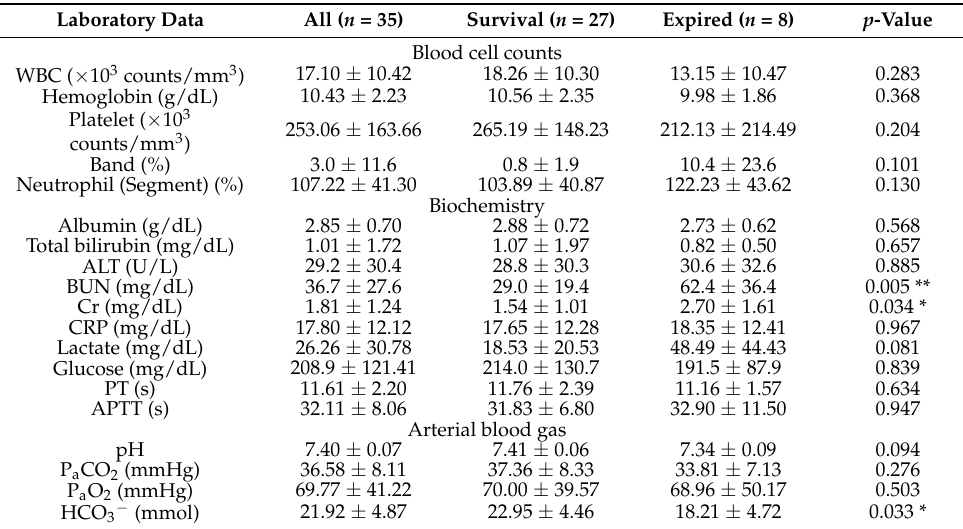
Table 2. Laboratory data of emphysematous cystitis.